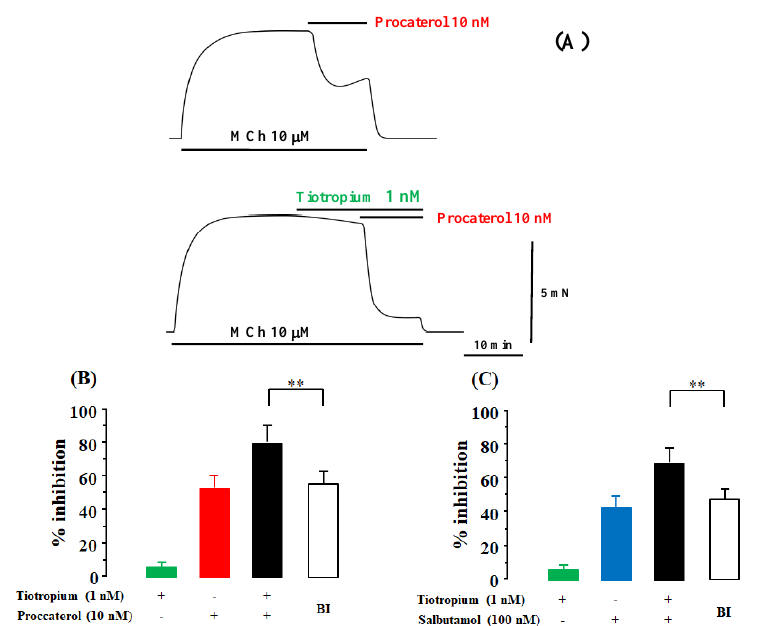
Figure 1. Synergistic effects of combination of β 2 -adrenergic receptor agonists with muscarinic receptor antagonists in airway smooth muscle. ( A ) Typical results of the inhibitory effect of procaterol (10 nM) in the absence (upper side) and presence (lower side) of tiotropium (1 nM) against methacholine (MCh, 10 μM )-induced contraction; ( B ) Values of percent inhibition of tiotropium (1 nM), procaterol (10 nM), and the combination of these two agents; ( C ) Values of percent inhibition of tiotropium (1 nM), salbutamol (100 nM), and the combination of these two agents. BI: the values of percent inhibition predicted by the Bliss independence theory, **: p <